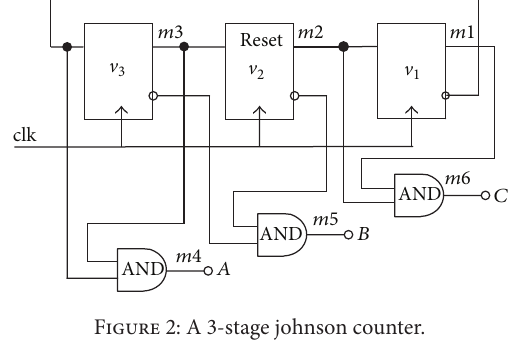
Figure 2: A 3-stage johnson counter.